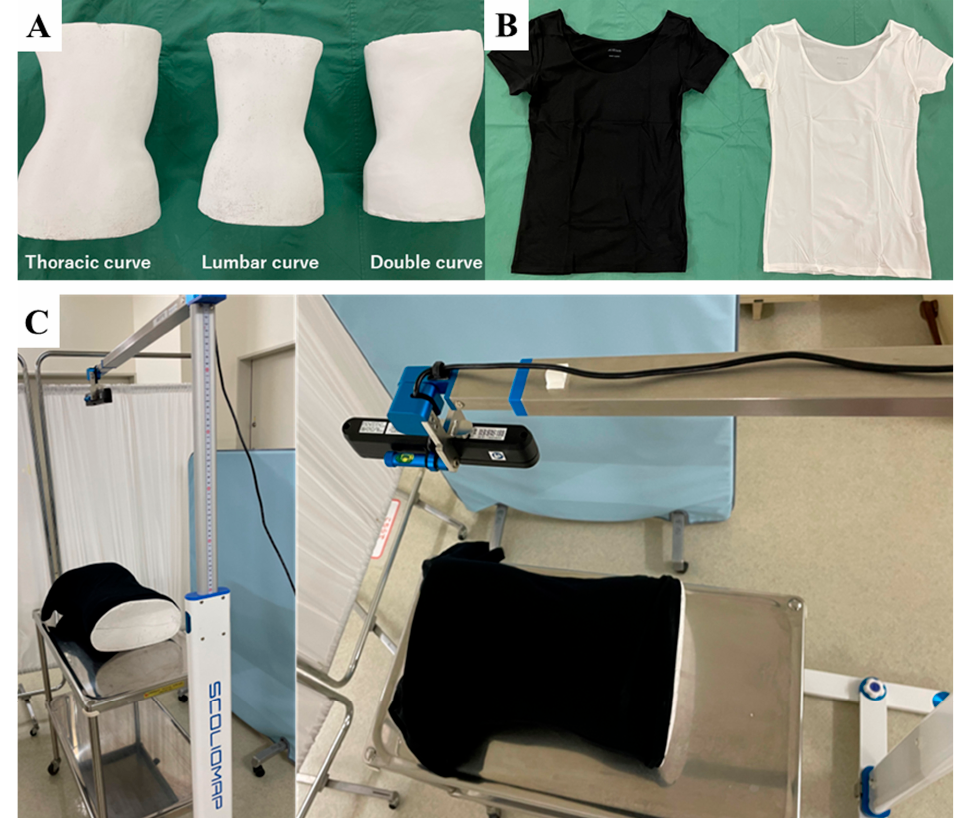
Figure 3. ( A ) Three different phantom models were obtained from plaster wrap castings to make hard braces for single thoracic curve, single thoracolumbar/lumbar curve, and double thoracic and double thoracolumbar/lumbar curve. ( B ) Black and white underwear types were used. ( C ). A shooting scene.